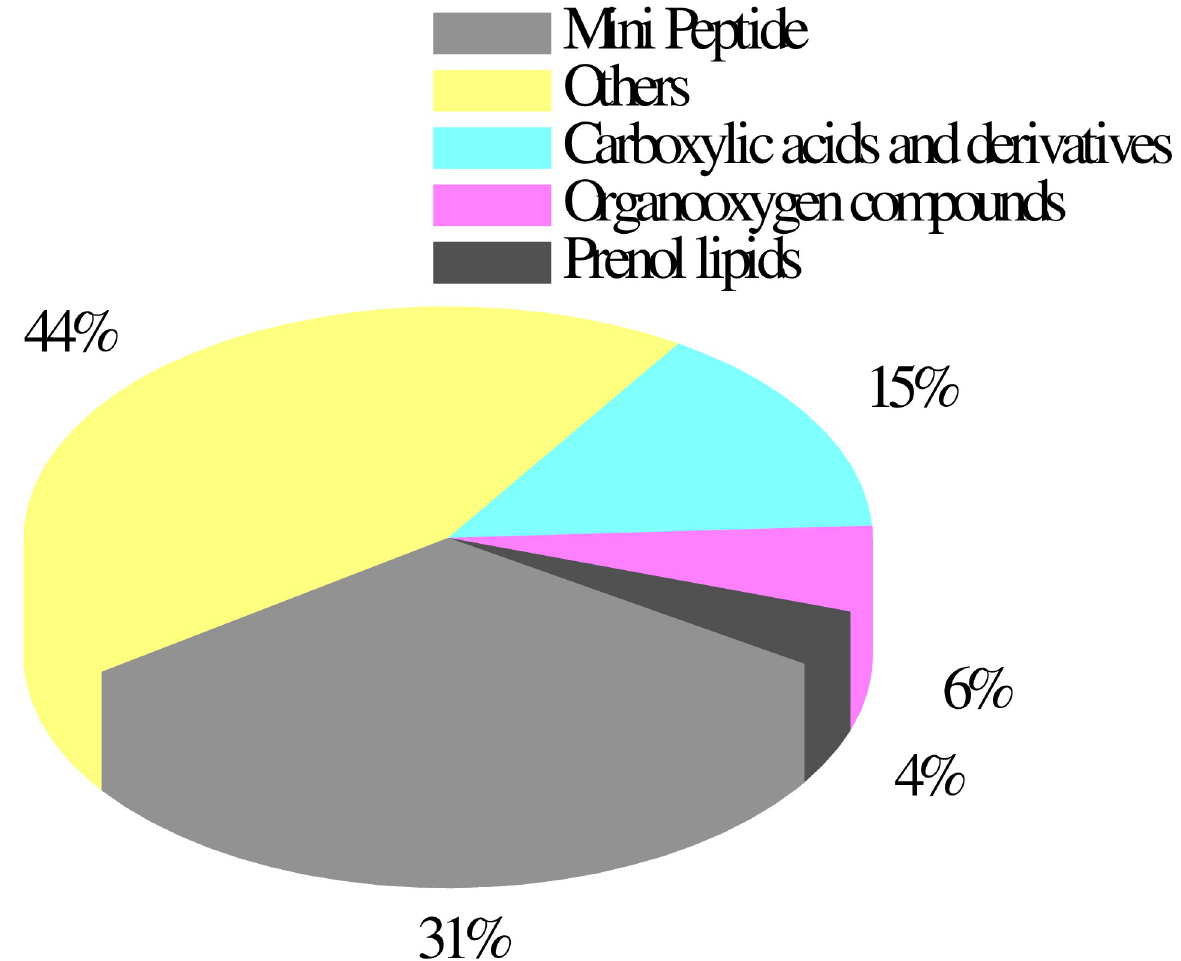
Fig 8. Differentially accumulated metabolites in the C . maxima after cold stress mainly belonged to four